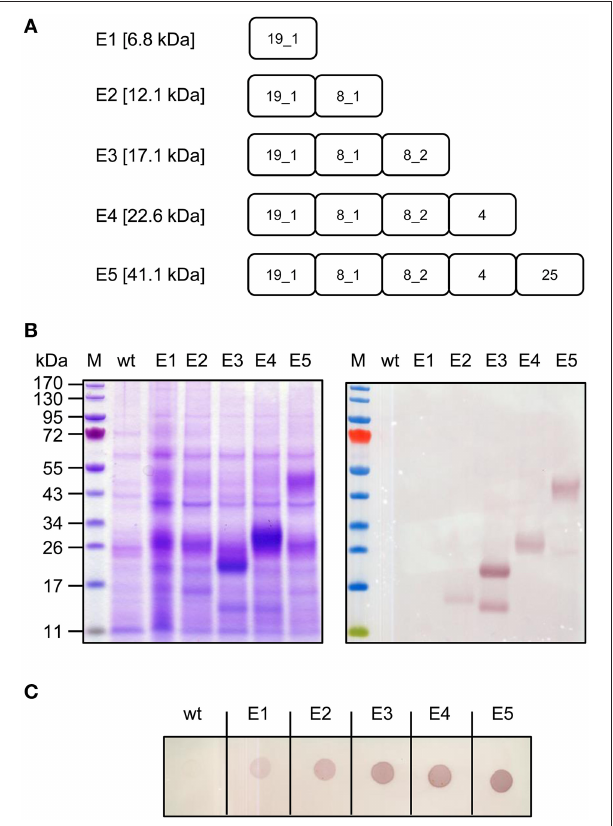
FIGURE 7 | Construction and expression of the multi-EGF dual-stage vaccine candidate (variants E1–E5). (A) Construct architecture. For antigen abbreviations refer to Table 1 . (B) SDS-PAGE and western blot analysis of dual-stage candidate variants. Heat-treated crude extracts were separated under reducing conditions and analyzed by staining with Coomassie (left panel) or by western blot using rabbit anti-His 6 and alkaline phosphatase-labeled goat anti-rabbit antiserum. M, PageRuler TM pre-stained protein ladder (Fermentas); wt, non-infiltrated leaf extract. (C) Dot-blot analysis of heat-treated crude extracts detected under non-reducing conditions using a Pf Msp1-19_EGF1-specific monoclonal antibody to confirm minimal expression of the single EGF1 domain of PfMsp1-19 and the proper folding of this domain. Binding was detected using goat anti-mouse alkaline phosphatase-labeled